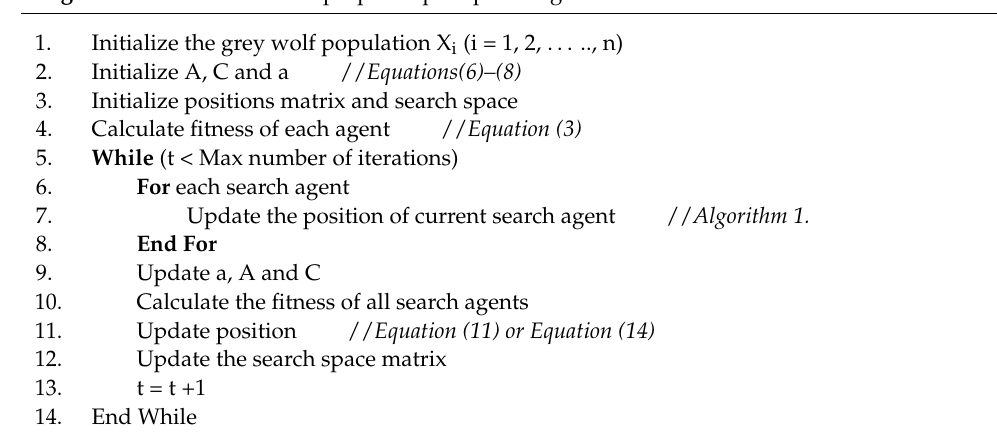
Algorithm 2. Pseudocode of proposed path